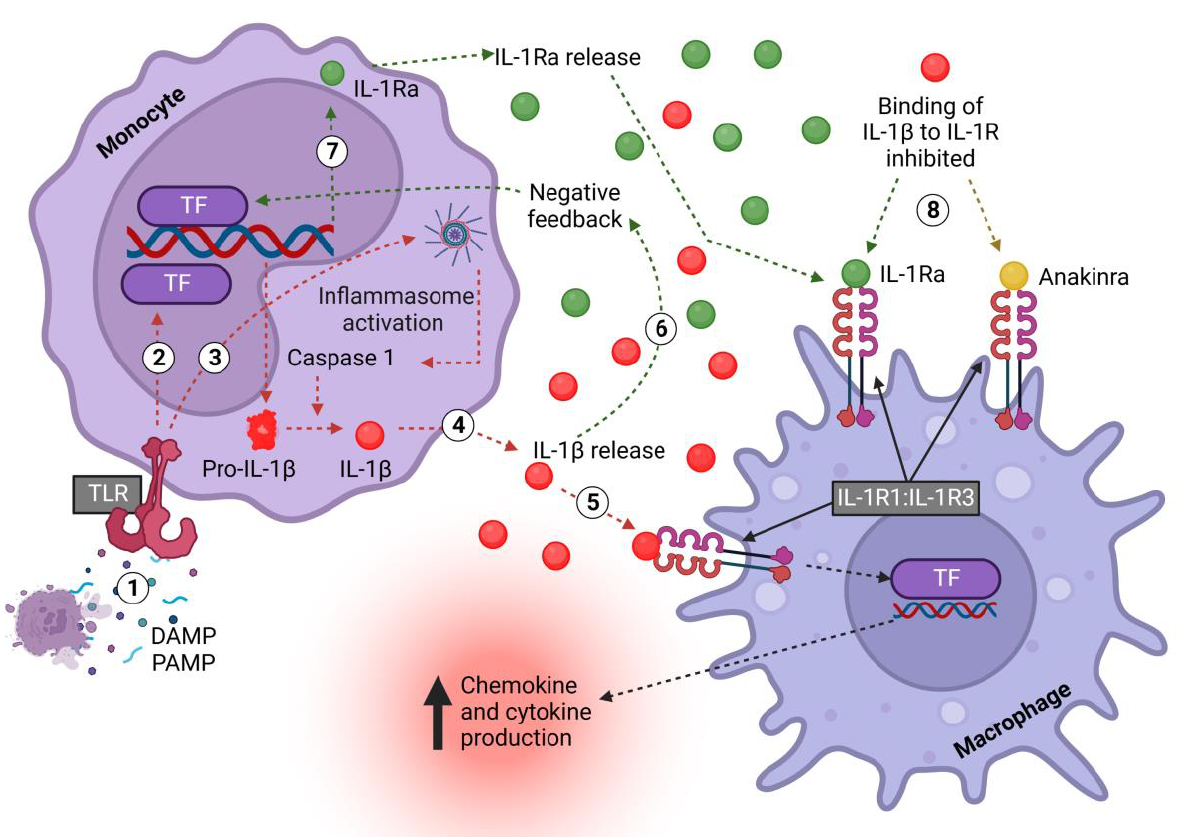
Figure 2. Monocyte-derived IL- 1β and IL -1Ra signaling pathway in macrophages. (1) DAMPS/PAMPS bind TLRs on monocytes and (2) activate downstream TFs, which induce the tran- scription of pro-IL- 1β and release into the cell cytoplasm. (3) In monocytes, TLR signaling also in-